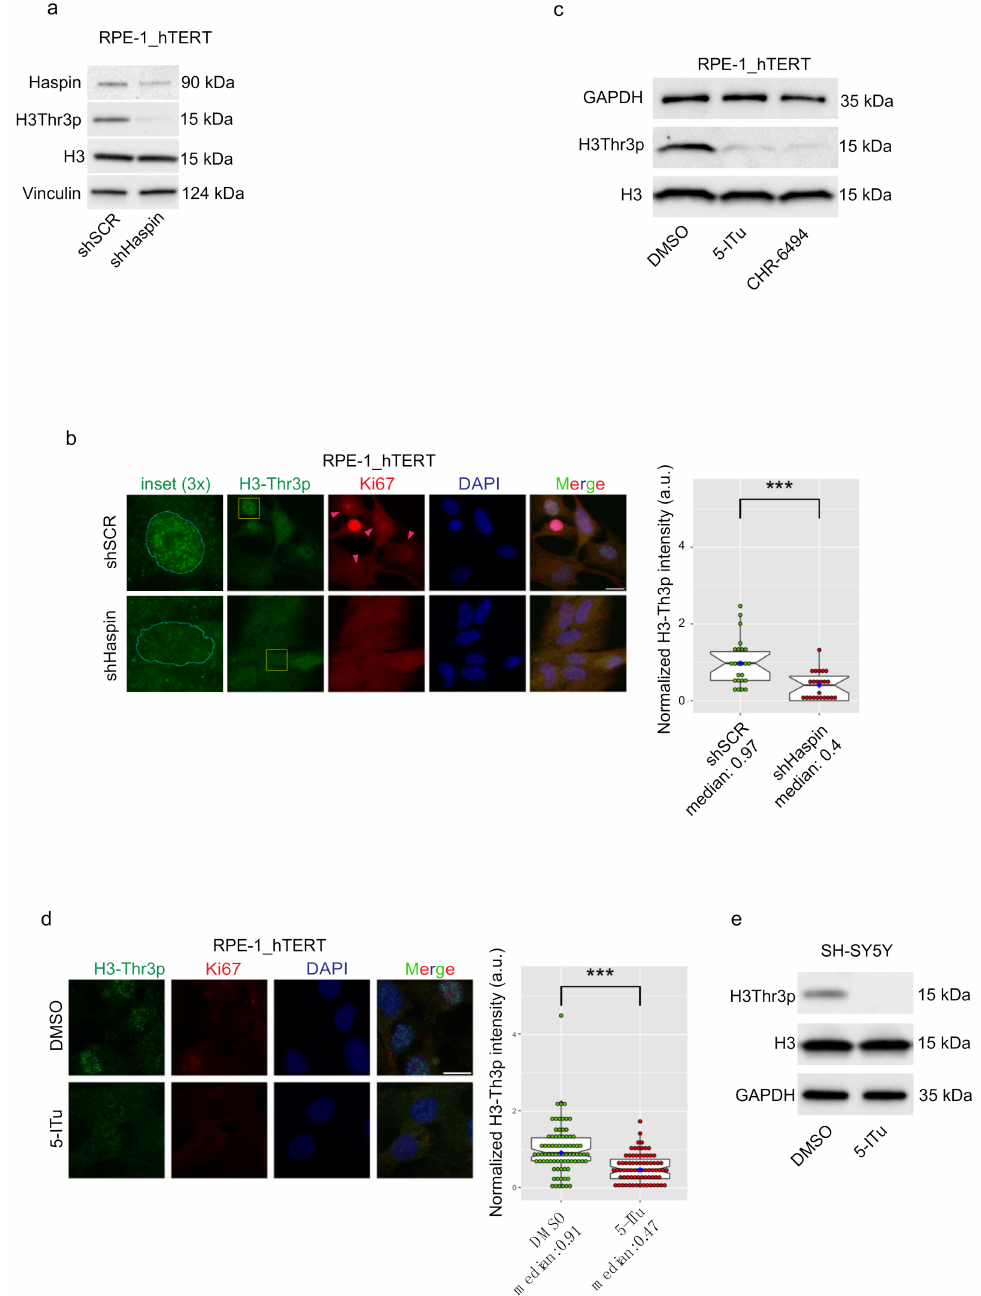
Figure 1. Haspin is active in G 0 phase. ( a ) RPE-1_hTERT cells stably silenced with shSCR (control) or shHaspin were seeded and harvested after 48 h serum starvation to induce entry in G 0 . Silencing efficiency and H3-T3 phosphorylation were monitored by Western blotting; ( b ) immunofluorescence against Ki67 (proliferation marker) and H3-T3 in shSCR and shHaspin cells serum-starved for 48 h. Histone phosphorylation was quantified and is reported to the right. Silencing control is shown in Supplementary Figure S1e; ( c ) RPE-1_hTERT cells were seeded and serum-starved for 48 h, then treated for a further 24 h with DMSO or Haspin inhibitor 5-ITu (10 nM) and CHR-6494 (50 nM); H3T3p was monitored by Western blotting; ( d ) cells treated with 5-ITu were processed for immunofluorescence against Ki67 and H3-T3. Histone phosphorylation was quantified and is reported to the right; ( e ) Western blot analysis monitoring the levels of H3-T3p in SH-SY5Y that were differentiated into neuron-like cells, as described in Material and Methods, and then incubated for 24 h with 10 nM 5-ITu. Graphs in b, d show the median abundance of phosphorylated H3-Thr3; boxes include 50% of the data points, notch represent confidence interval (median ± 1.58 IQR/sqrt(n)). t -test was applied as a statistical measurement, n.s.; not significant, *** p < 0.005. Scale bars in b, d: 20 µ